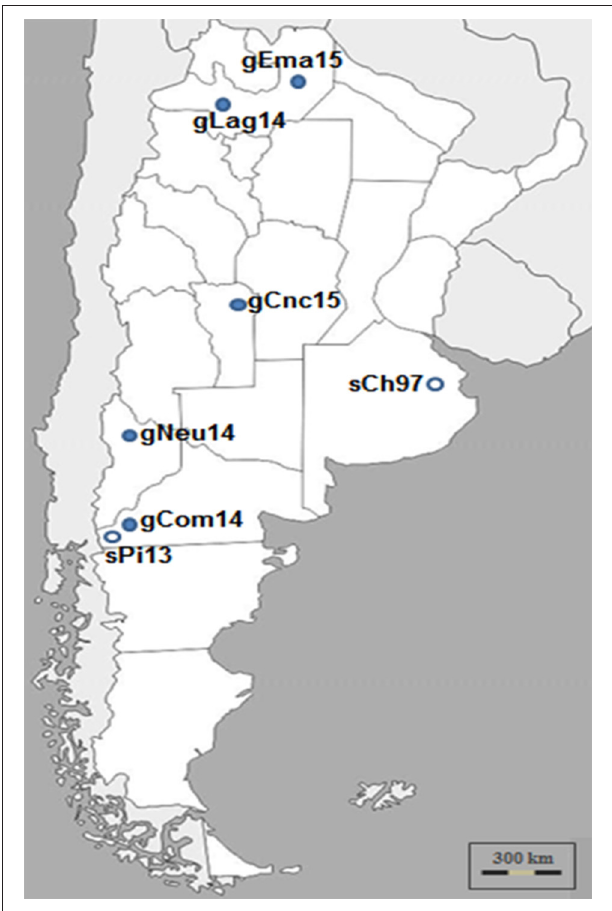
FIGURE 1 | Argentinian ORFV analyzed in this study. ORFV samples were obtained during Contagious Ecthyma outbreaks from different regions of Argentina and time points. Dark circles indicate Ecthyma outbreaks occurred in goats while white circles outbreaks in sheep (17).